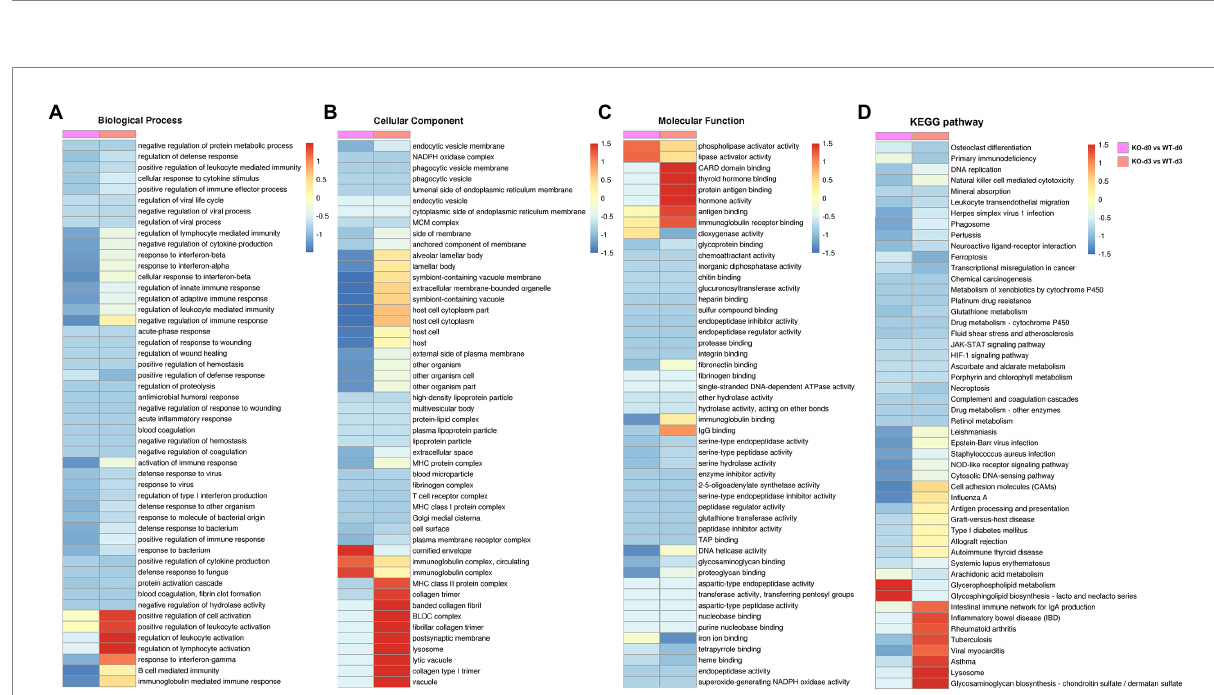
FIGURE 4 Enrichment analysis of identified DEPs in KO-d0 vs. WT-d0 and KO-d3 vs. WT-d3 groups after influenza virus infection. Classification of these proteins in different categories based on biological process (A) , cellular component (B) and molecular function (C) . (D) KEGG enrichment analysis of the DEPs in WT and KO mice lung tissues after influenza virus infection at 0 dpi and 3 dpi,